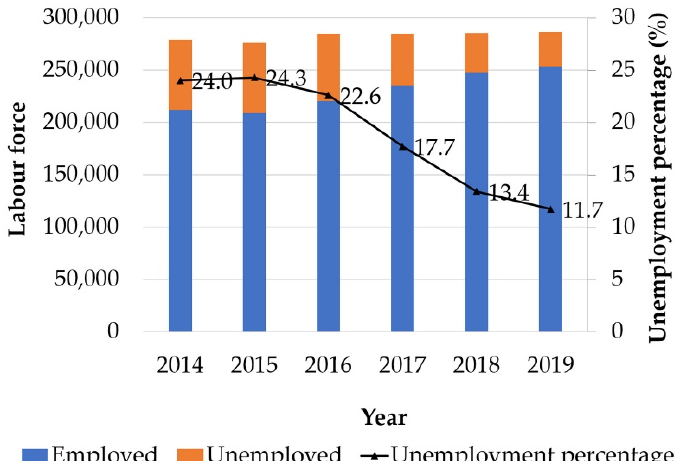
Figure 4. Unemployment data in Crete since 2014 [49].